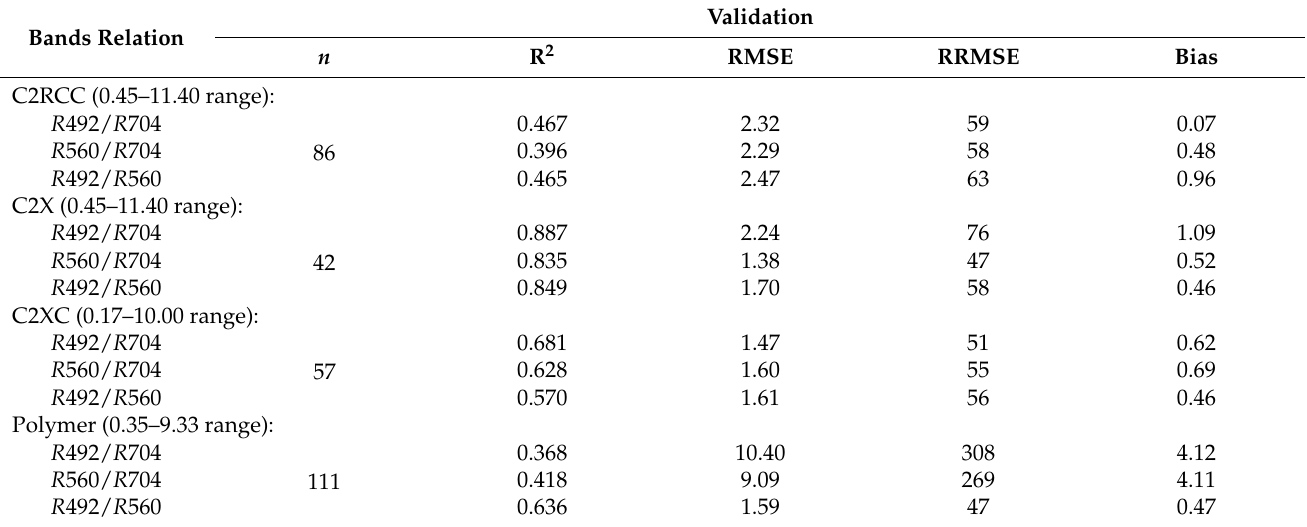
Table A2. SDD (m) validation results for in situ spectrometry waters quality algorithms and AC type.